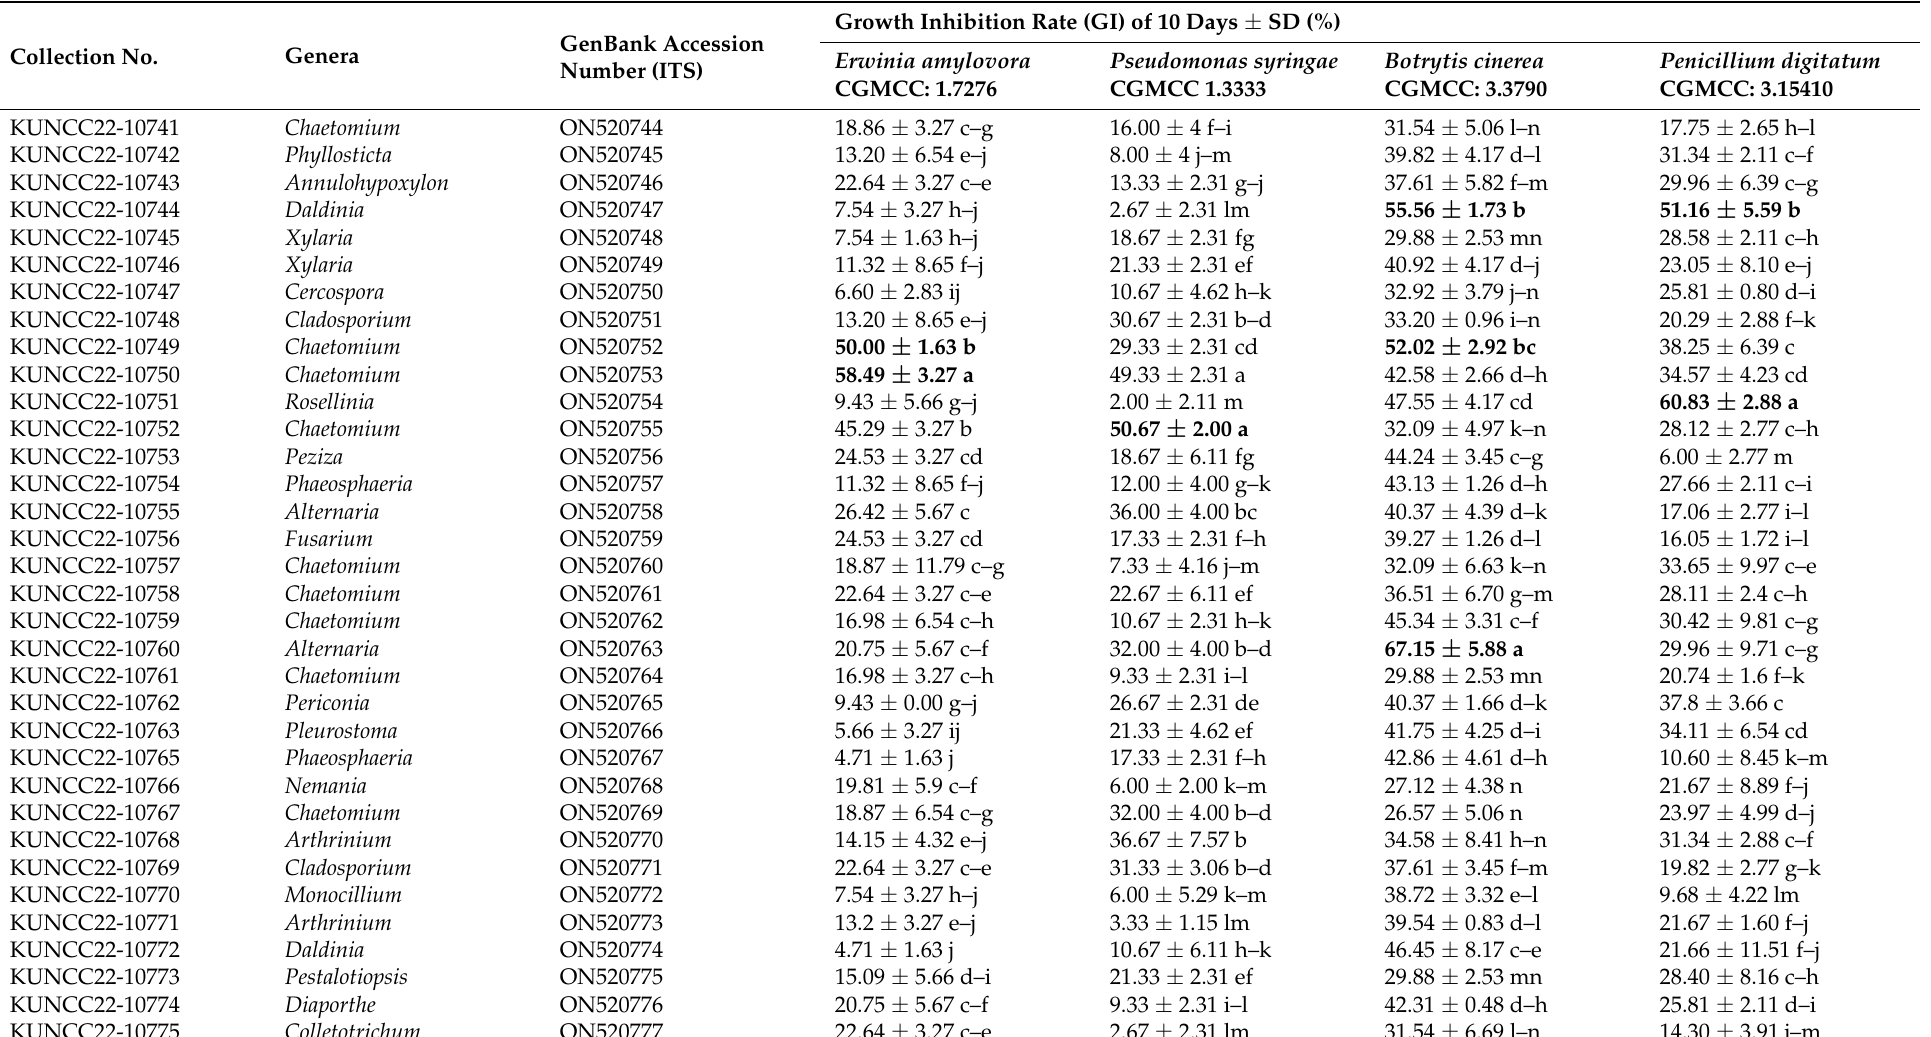
Table 2. The radial growth inhibition rates of fungal and bacterial pathogens. Inhibitions equal to or greater than 50% are in black bold.